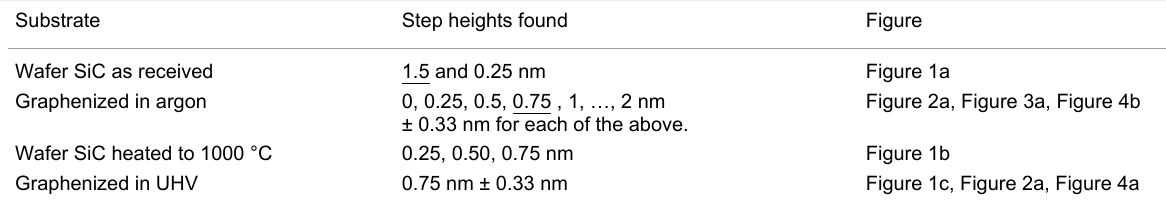
Table 1: Table of different step heights found before and after graphenization of 6H-SiC(1000). Dominant step heights are underlined. After graphen- ization the substrate step heights formed as multiples of the SiC(0001) bilayer height of 0.25 nm may vary by the graphene thickness of 0.33 nm. Substrate Step heights